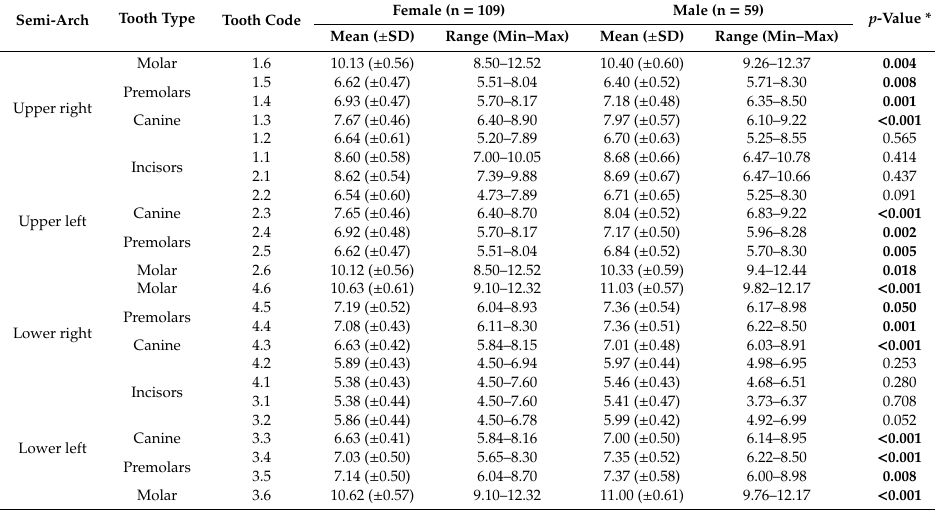
Table 1. Descriptive values of mesiodistal width (mm), presented as mean and standard deviation (SD) for each tooth, as a function of sex (n =